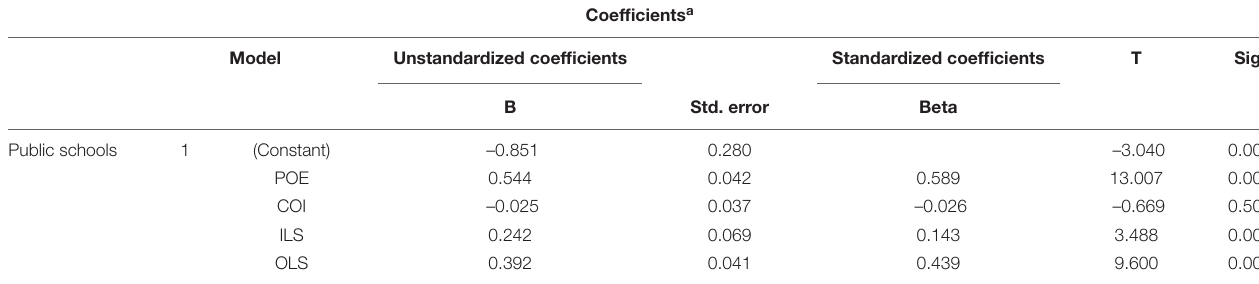
TABLE 8 | Coefficients of grit and L2MSS for public school